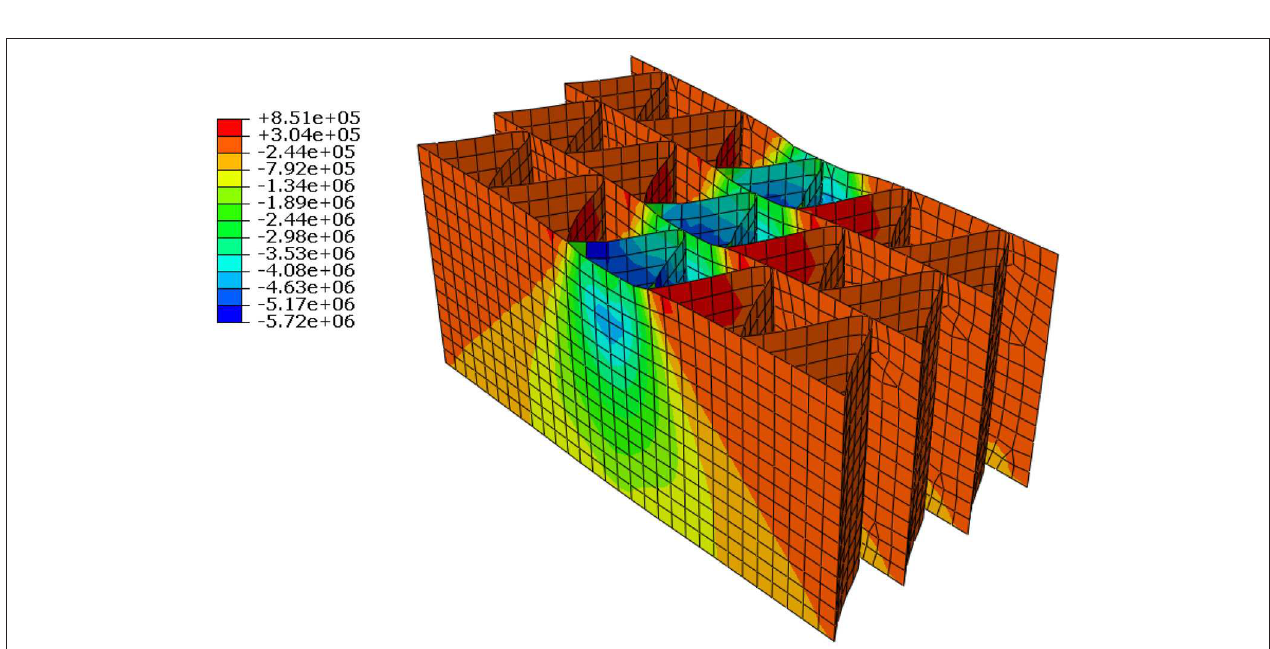
Frontiers in Built Environment |